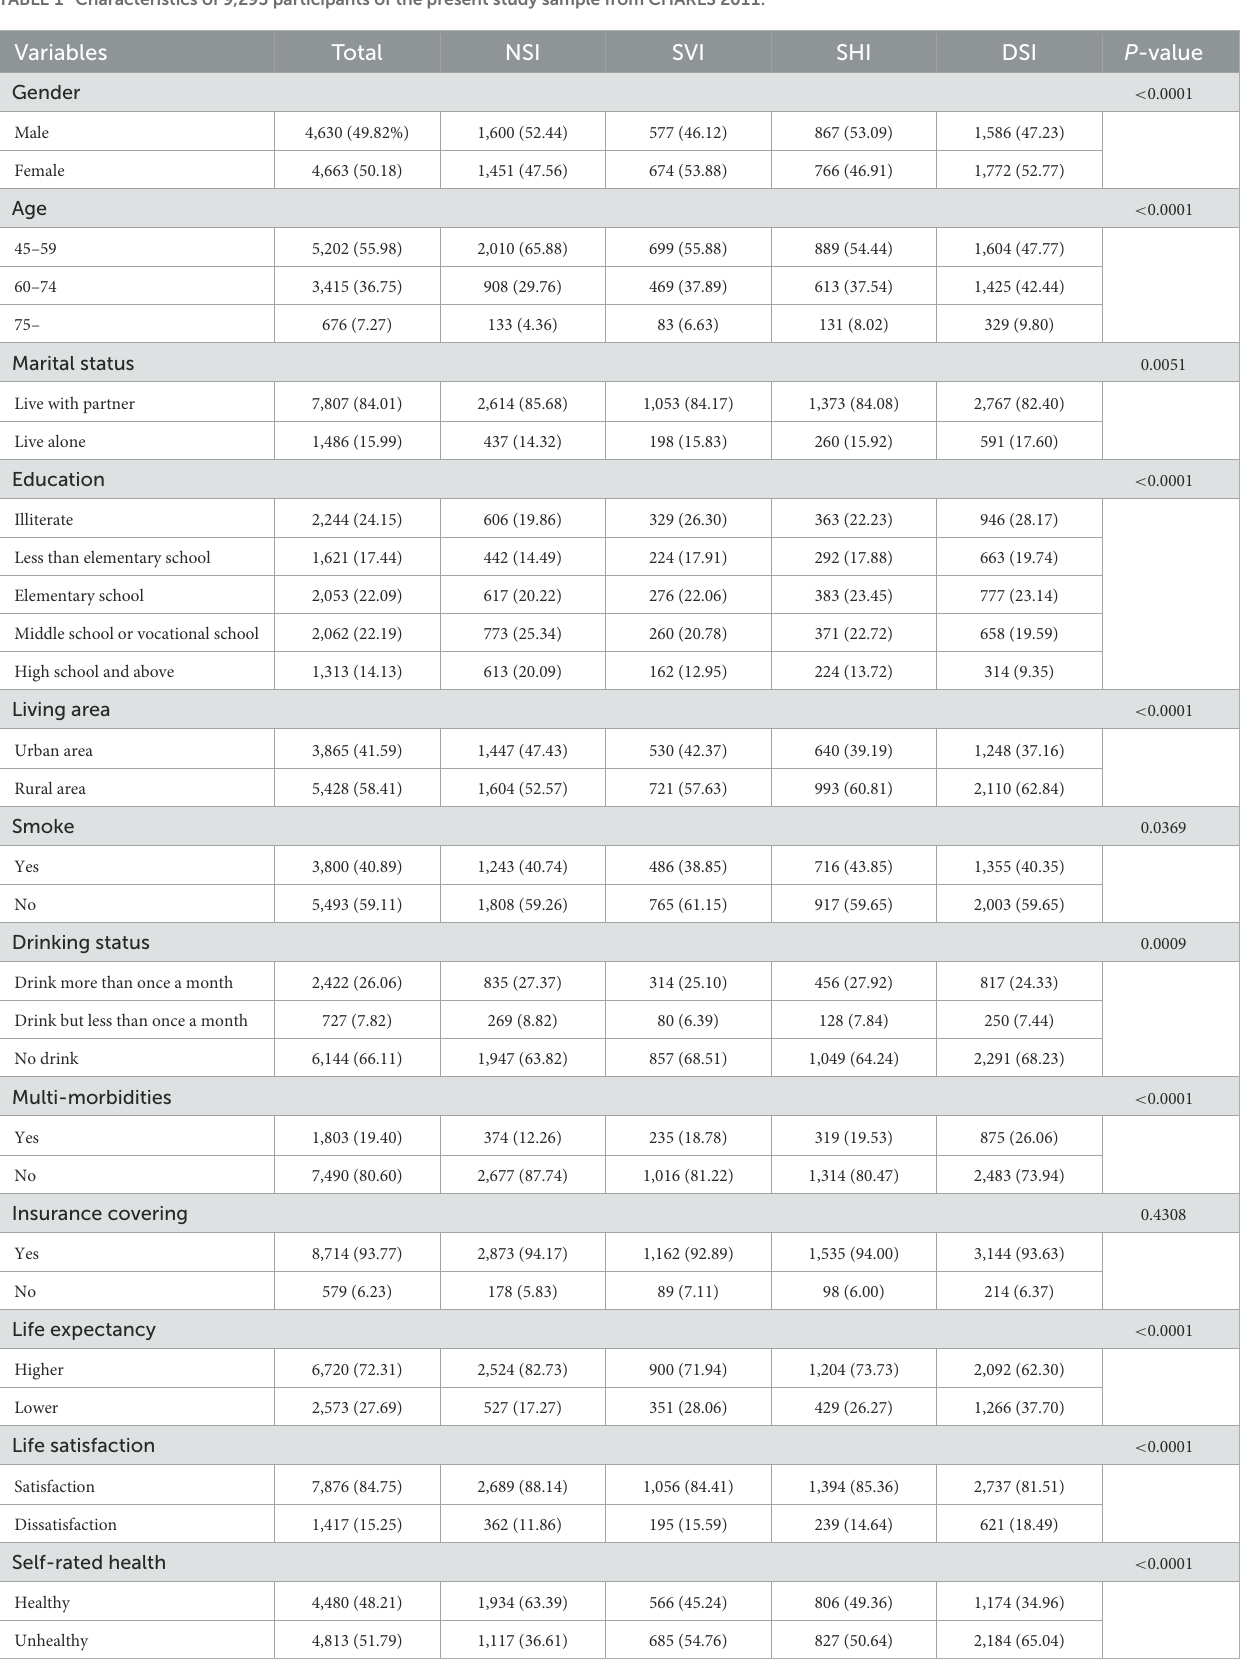
TABLE 1 Characteristics of 9,293 participants of the present study sample from CHARLS